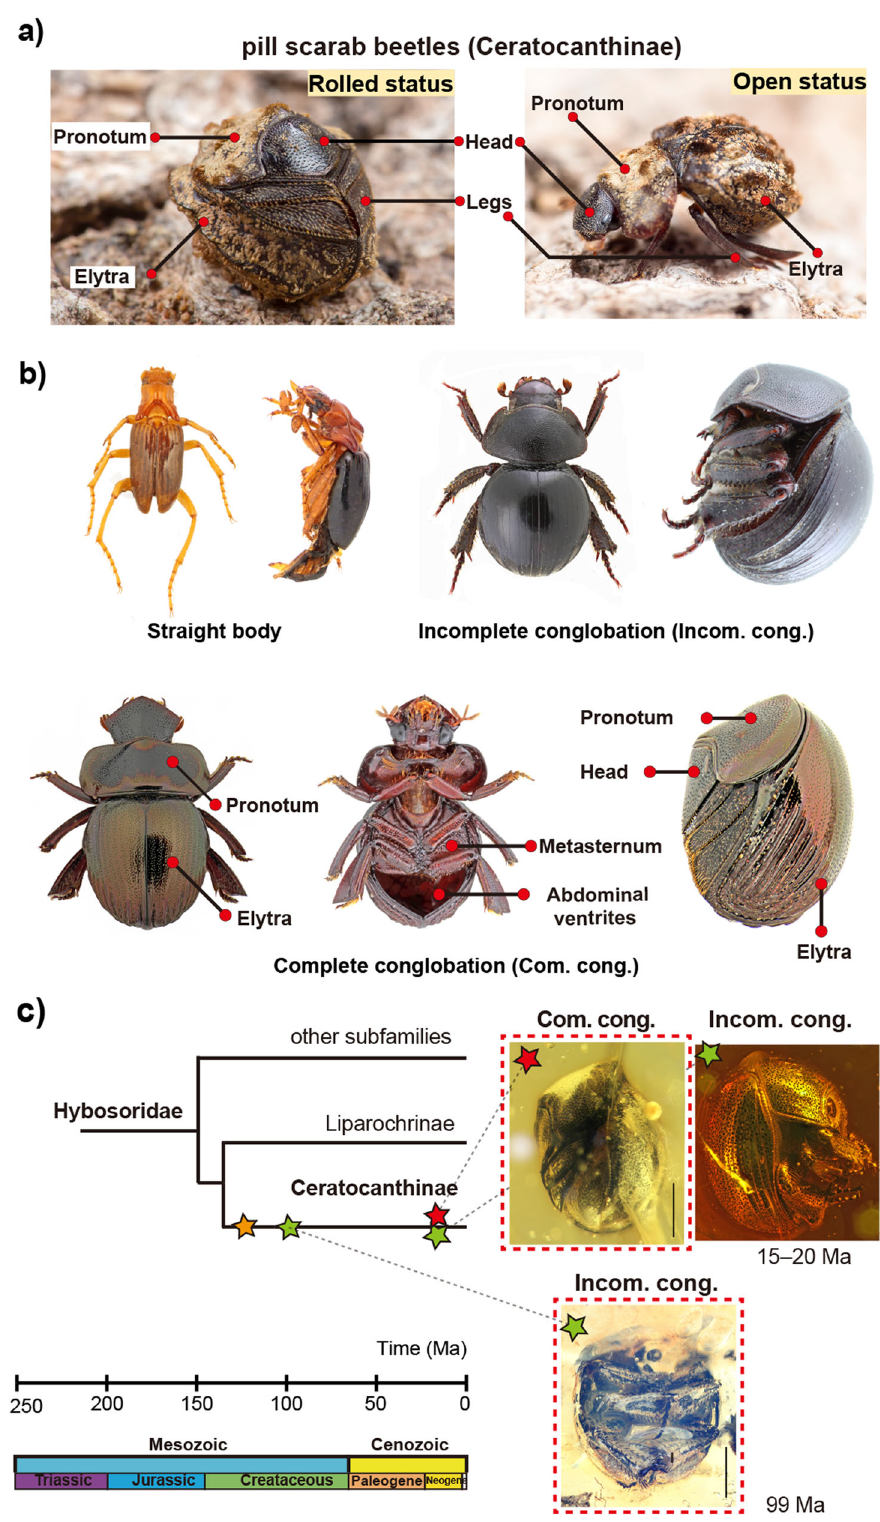
Fig. 1 Conglobation behaviours of pill scarab beetles. a Two postures of a pill scarab beetle with complete conglobation: Paulianostes panggoling , Malaysia (Insecta: Coleoptera: Ceratocanthinae). b Three archetypes of conglobation in Ceratocanthinae: straight body ( Ivieolus brooksi ), incomplete conglobation ( Acanthocerodes sp.), and complete conglobation ( Synarmostes tibialis ). c Fossil records of Ceratocanthinae. Yellow stars indicate fossils with a straight- body archetype from the Yixian Formation (125 Ma) ( Mesoceratocanthus tuberculifrons ), green stars indicate fossils with an incomplete conglobation archetype from Kachin amber (99 Ma) ( Palaeopycnus circus Lu, Ballerio & Bai sp. nov.) and from Dominican amber (15 – 20 Ma) ( Germarostes sp.), and red stars indicate fossils with a complete conglobation archetype from Dominican amber (15 – 20 Ma) ( Nesopalla succini Lu, Ballerio & Bai sp. nov.). Red dashed box indicates new reports in here. a ©Zhengzhong